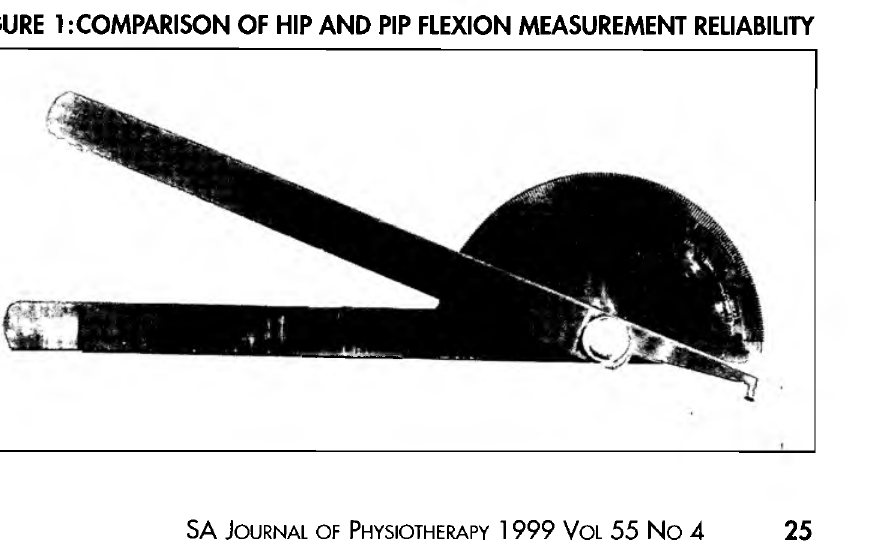
FIGURE 1: COMPARISON OF HIP AND PIP FLEXION MEASUREMENT